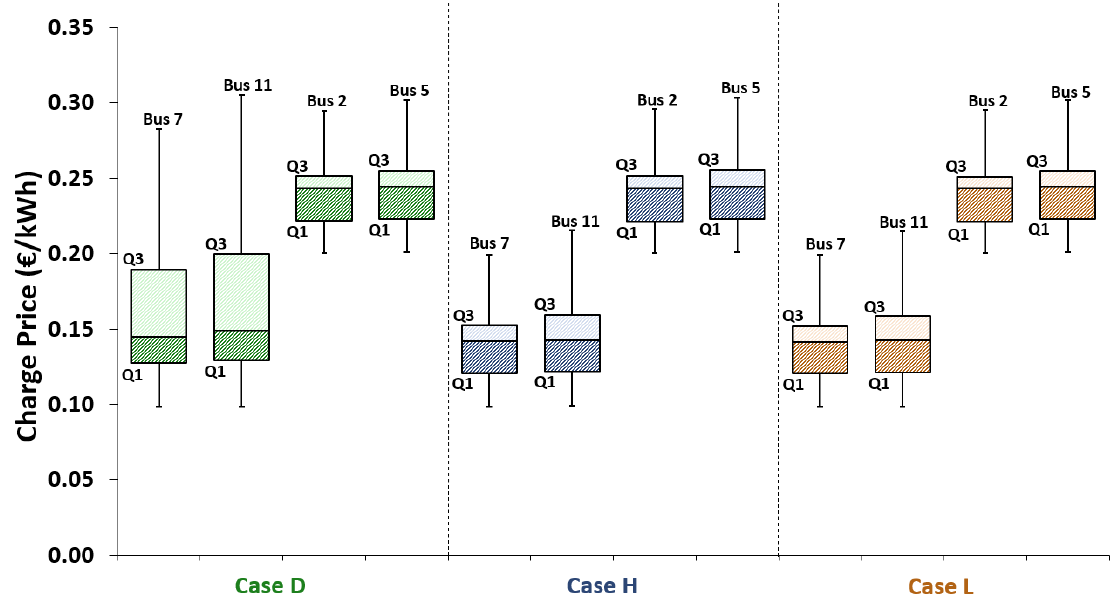
Figure 15. Electric vehicle charge price variation for the user price preference scenario.